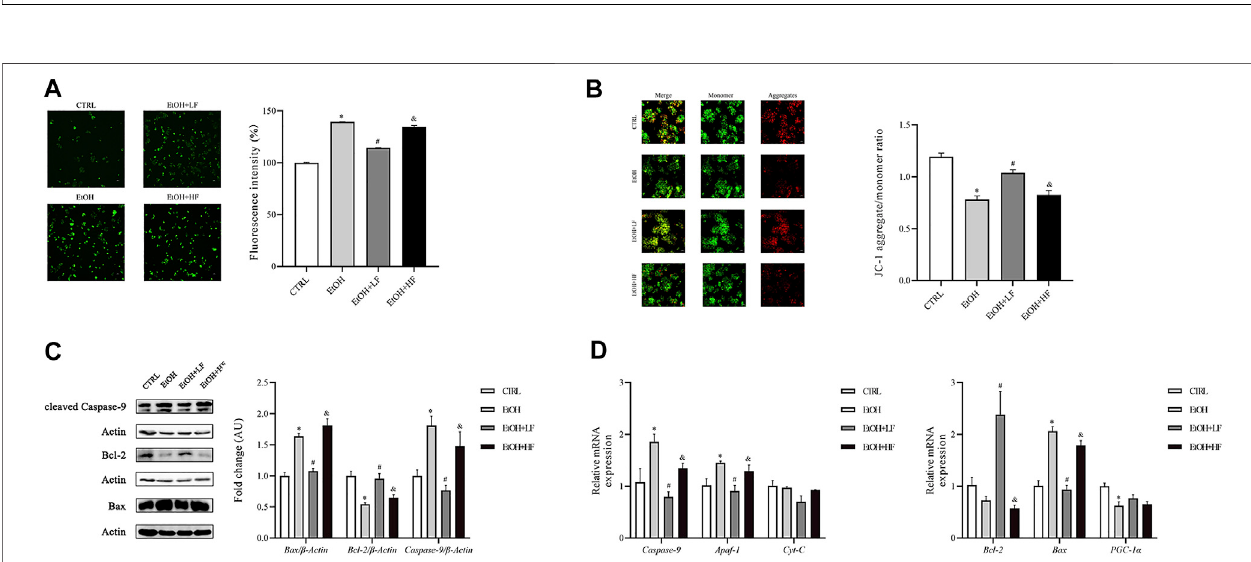
FIGURE 2 | Furfural normalized mitochondrial function in HepG2 cells treated with ethanol. (A) Reactive oxygen species (ROS) levels as detected by DCFH-DA assay. The bar graph shows the fl uorescence intensity of DCFH-DA representing the general ROS levels. (B) JC-1 assay. The bar graph shows the ratio of aggregated JC-1 (red)/monomeric JC-1 (green), representing the mitochondrial membrane potential ( Δψ m). Scale bar: 50 μ m. (C) The relative expression of factors in the mitochondrial apoptosis pathway at the protein level. (D) The mRNA levels of factors in the mitochondrial apoptosis pathway and involved in oxidative stress damage, as measured by RT – qPCR. * p < 0.05, compared with the CTRL group; # p < 0.05, compared with the EtOH group; & p < 0.05, compared with the EtOH + LF group. Abbreviations: Apaf-1, apoptotic peptidase activating factor-1; CytC, cytochrome c.